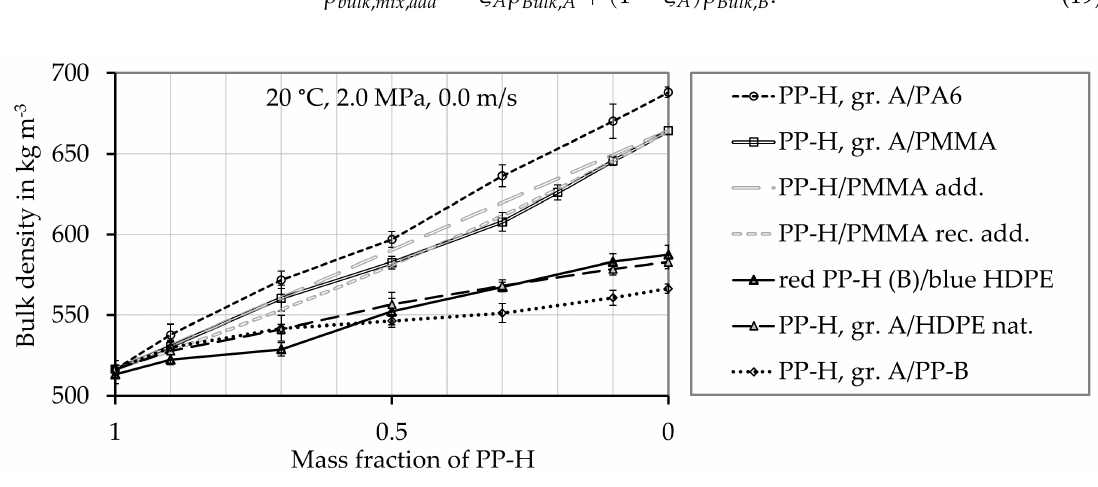
Figure 4. Density of the mixtures of the bulk material. The symbols show experimentally determined values, the black lines connect these experimentally determined values. The gray lines show the density of the PP-H / PMMA mixture calculated by the additivity and the reciprocal additivity relationship model. Equation (19) is only a first approach to calculate the bulk density of the polymer